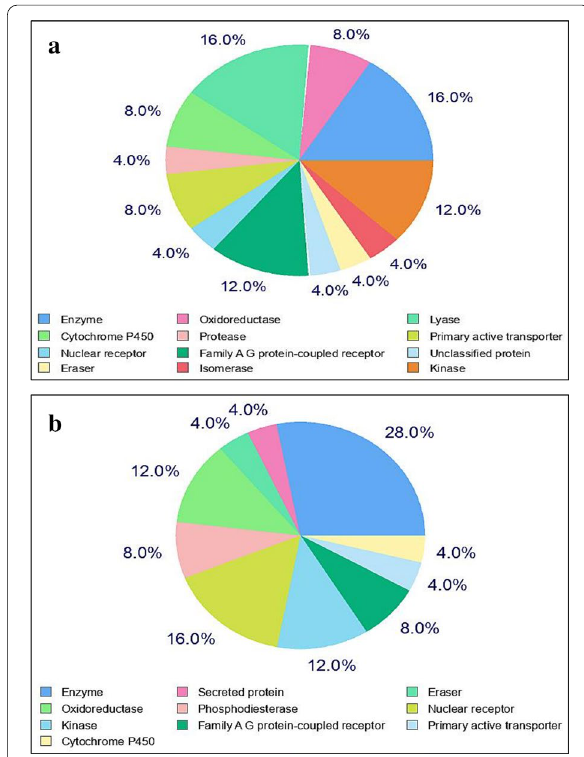
Fig. 9 Top 25 classes of molecular targets within H. sapiens predicted for a C3/luteolin and b C43/abyssinone